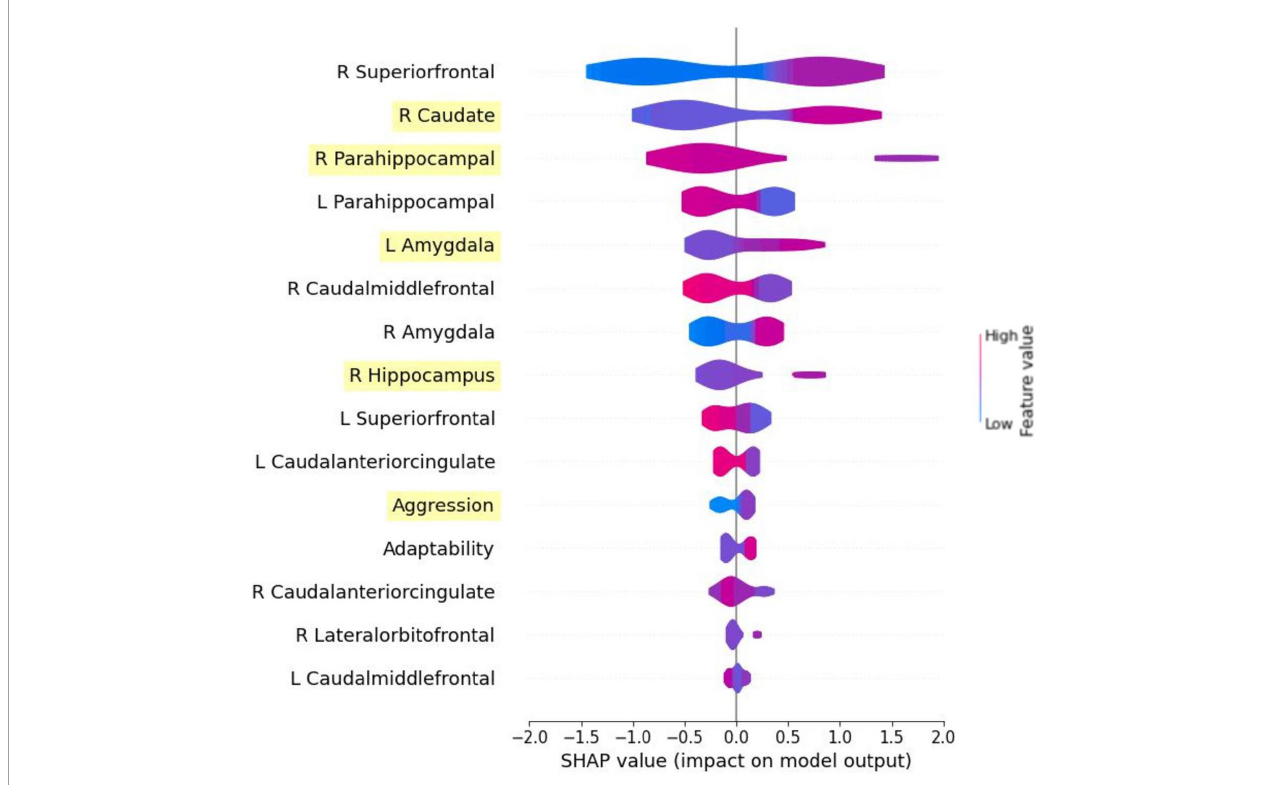
FIGURE4 Summary plot in SHAP generated from the model using all features. Only the top 15 features are shown. Features highlighted are those selected from RFE method. To interpret the SHAP plot, the warmer color of the feature bars represents the higher feature values, and the cold color represents the lower feature values. When the SHAP value is higher and >0 the model is more likely to predict 1 (Sandy exposure), and when the value is lower and <0 the model is more likely to predict 0 (non-Sandy